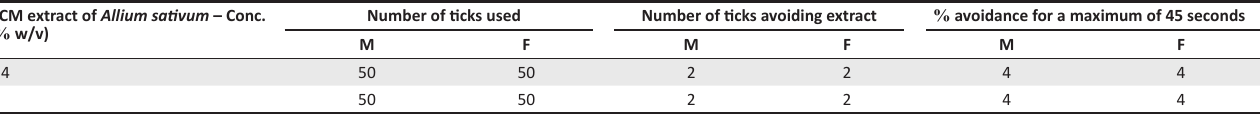
FIGURE 1: Relationship between % repellency and concentrations of dichloromethane extract of Allium sativum on adults of Hyalomma rufipes in the Type A repellency bioassay. TABLE 2: Summary of the results obtained in the Type B repellency bioassay using dichloromethane extracts of Allium sativum against males and females of Hyalomma rufipes . DCM extract of Allium sativum – Conc. Number of ticks used Number of ticks avoiding ( % w/v)